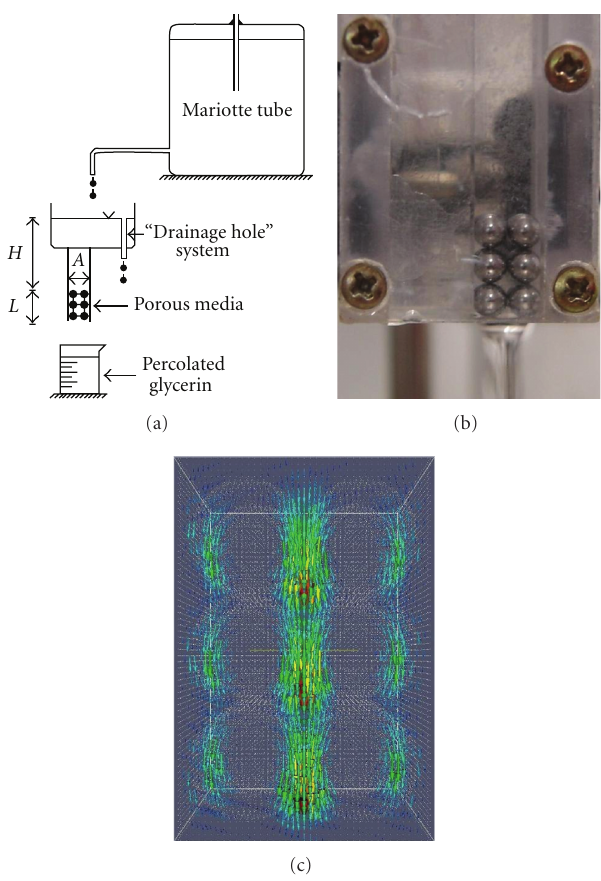
Figure 1: (a) Schematic drawing of the experimental apparatus used; (b) example of a regular arrangement of spheres. The box used to contain the spheres has the following measurements 0.635 cm × 0.635 cm × 4.7 cm (width × height × length) and the diameter of spheres used is 0.3175 cm; (c) velocities field for 3 layers of